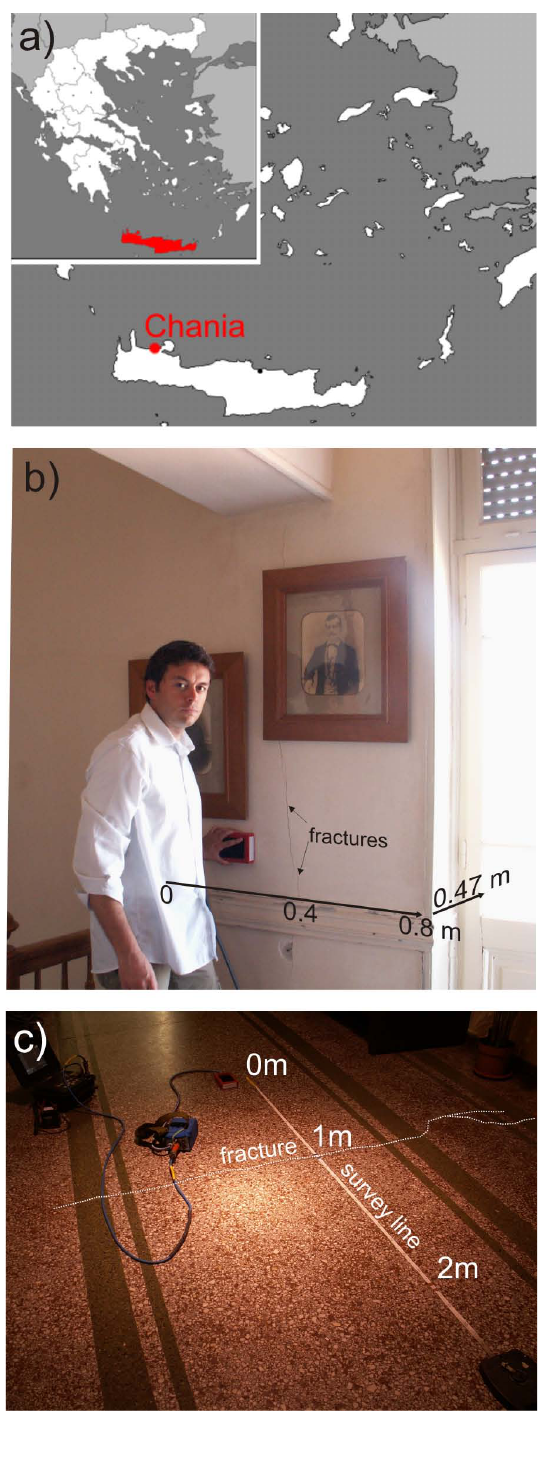
Fig. 2. (a) Crete island map; (b) survey line on a wall of Venize- los house; (c) survey carried out on a floor of Prefecture of Chania